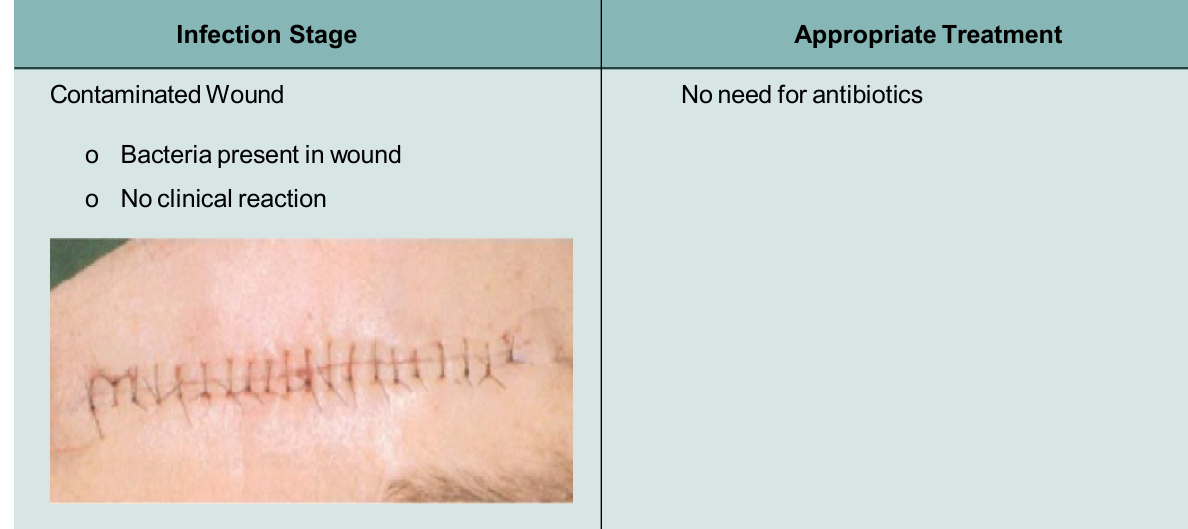
Table 5. Stages of infection and appropriate